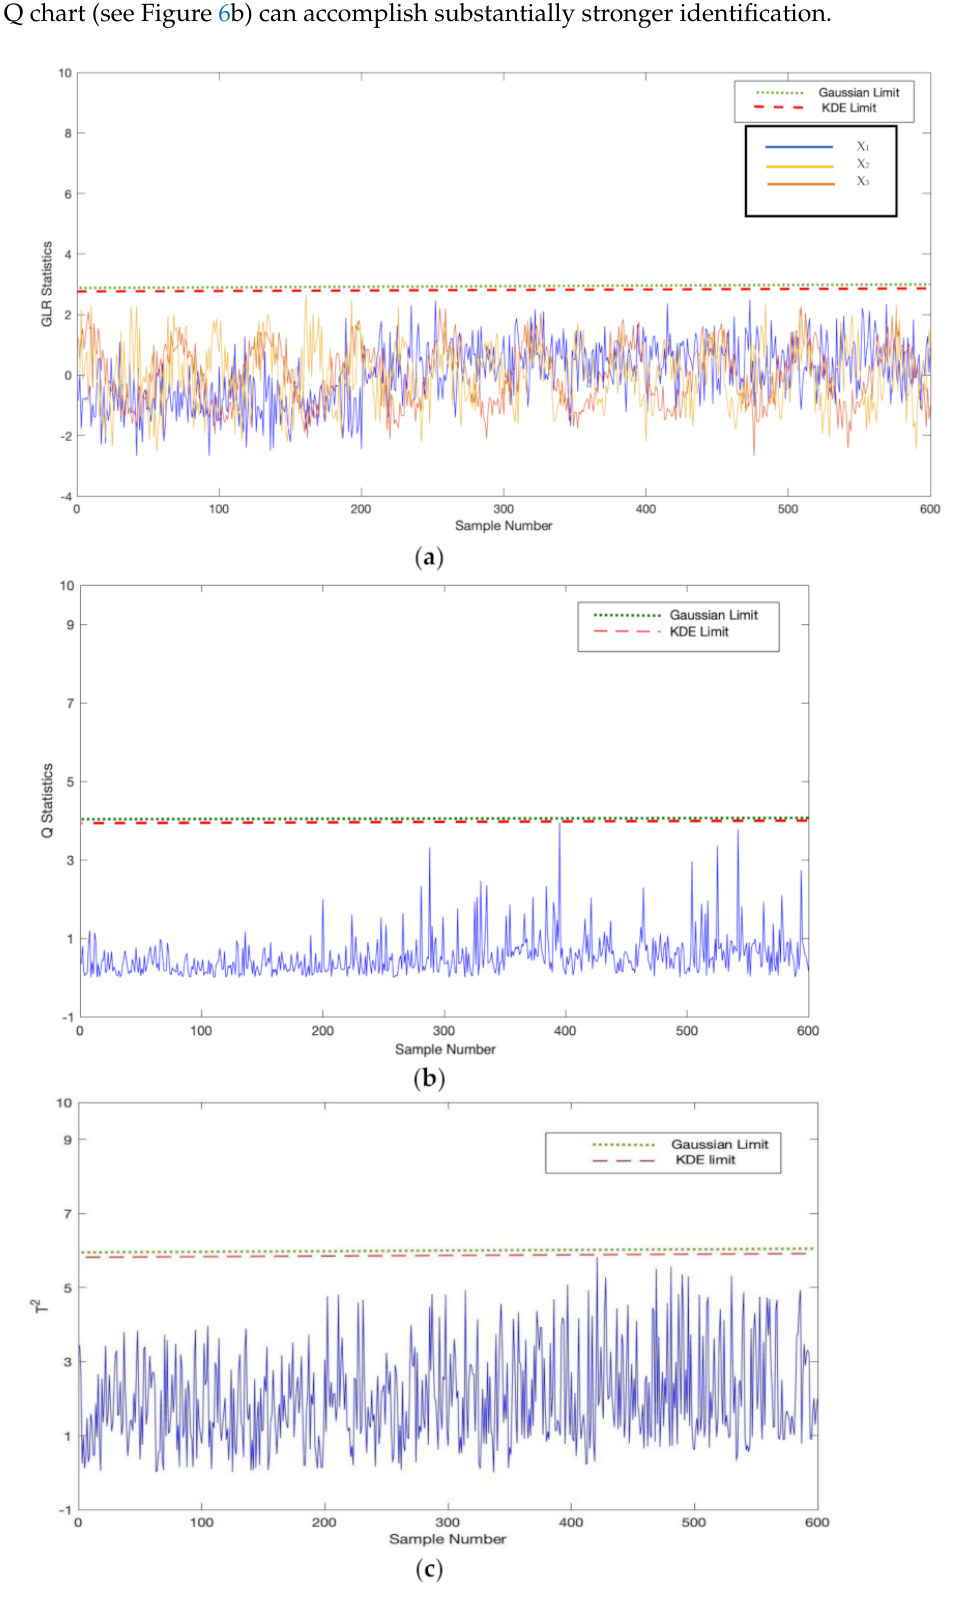
Figure 5. ( a ) KPCA-KDE-based SSGLR charts for the fault-free data; ( b ) KPCA-KDE-based Q chart for the fault-free data; ( c ) KPCA-KDE-based T 2 chart for the fault-free